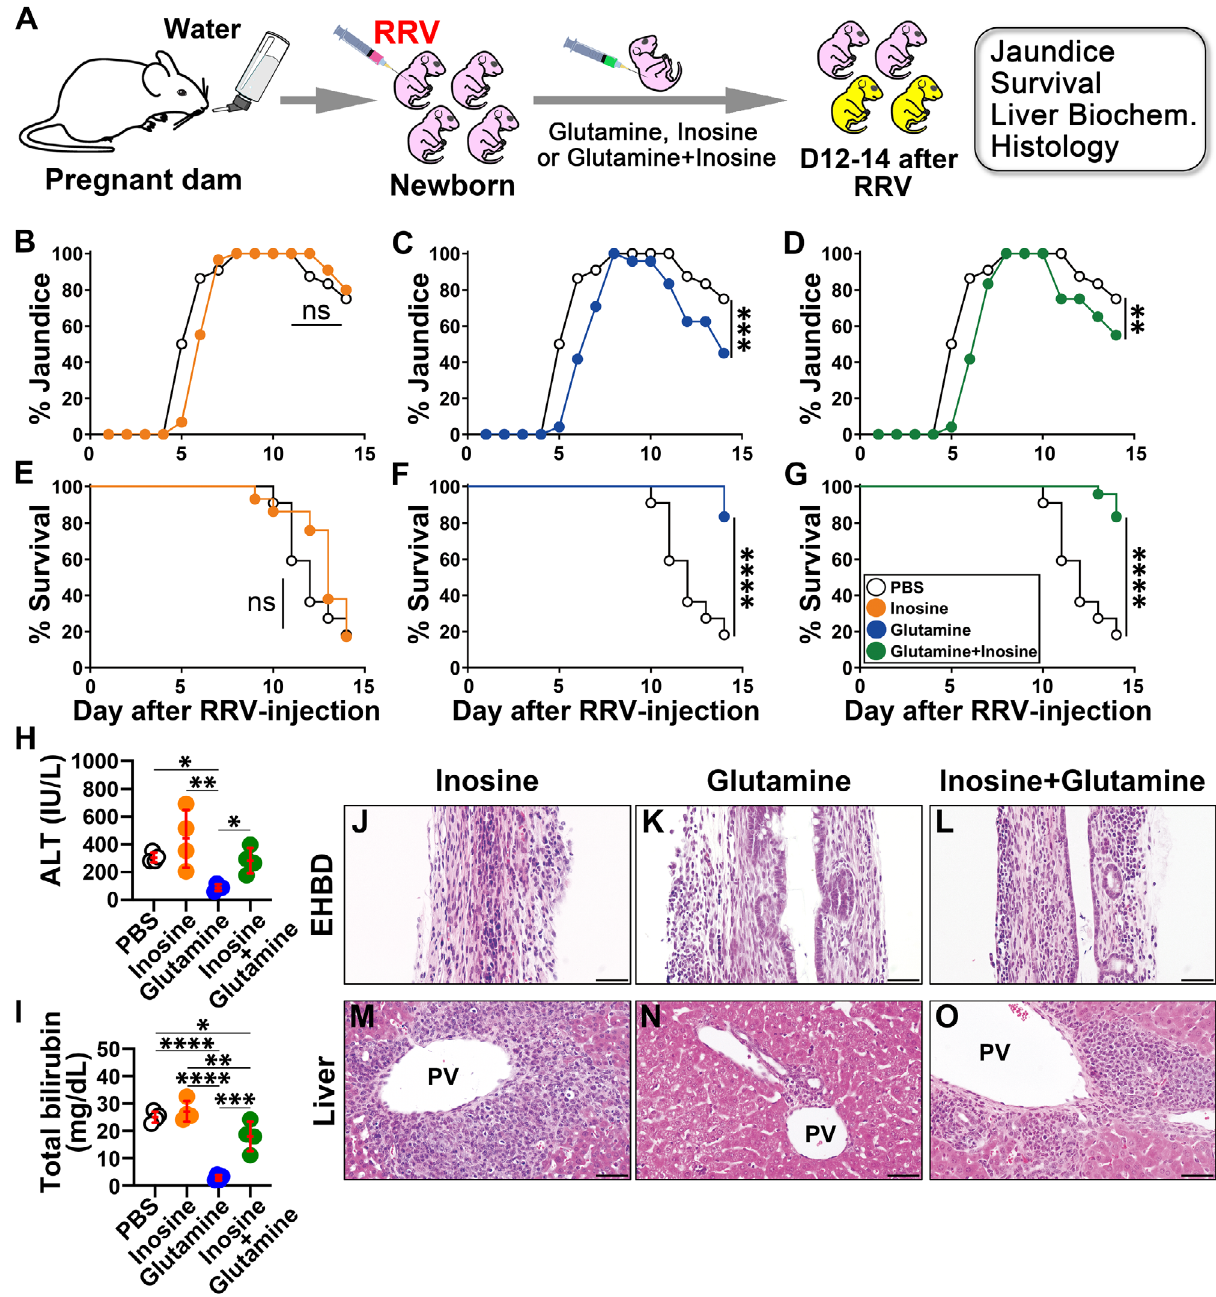
Fig. 6 Glutamine suppresses the obstructive phenotype of experimental biliary atresia and improves survival. A An experimental design for the treatment of RRV-infected neonatal mice with inosine and/or glutamine. B – D Incidence of jaundice in phosphate-buffered saline (PBS)-injected or RRV- infected newborn mice treated with intraperitoneal doses of inosine, glutamine, and inosine + glutamine ( n = 22 – 29 per group; generalized linear mixed effect model with logit link and two-sided Wald test with Bonferroni correction. ** p < 0.01, *** p < 0.001, ns = not signi fi cant). E – G Survival rates of neonatal mice treated with inosine ( E ), glutamine ( F ), and inosine + glutamine ( G ), compared to those receiving PBS (control) during the fi rst 2 weeks of life ( n = 22 – 29 per group; two-sided log-rank test for survival rate, **** p < 0.0001, ns = not signi fi cant). Plasma alanine aminotransferase (ALT, [ H ]) and total bilirubin levels ( I ) at days 12 – 14 after phosphate-buffered saline (PBS; Ctrl, n = 4) injection or RRV infection and daily treatment of inosine ( n = 4), glutamine ( n = 4), and inosine ± glutamine ( n = 4; mean ± SD, two-tailed ANOVA with Duncan ’ s multiple comparison; * p < 0.05, ** p < 0.01, *** p < 0.001, **** p < 0.0001). Hematoxylin – eosin-stained sections of extrahepatic bile ducts (EHBD) and livers sections ( J – O ) from newborn mice 12 – 14 days after RRV and daily treatment of inosine, glutamine, and inosine ± glutamine 12 – 14 days after RRV injection (magni fi cation bar = 100 μ m; PV portal vein; magni fi cation bar = 100 μ m). In all, 15 – 30 EHBD and 5 – 10 liver sections (corresponding to >100 sections at ×200 or ×400 magni fi cation fi elds from n = 9 – 11 mice) stained with H&E per tissue specimen were evaluated for histology analysis. Source data for this fi gure are provided as a Source data fi le.